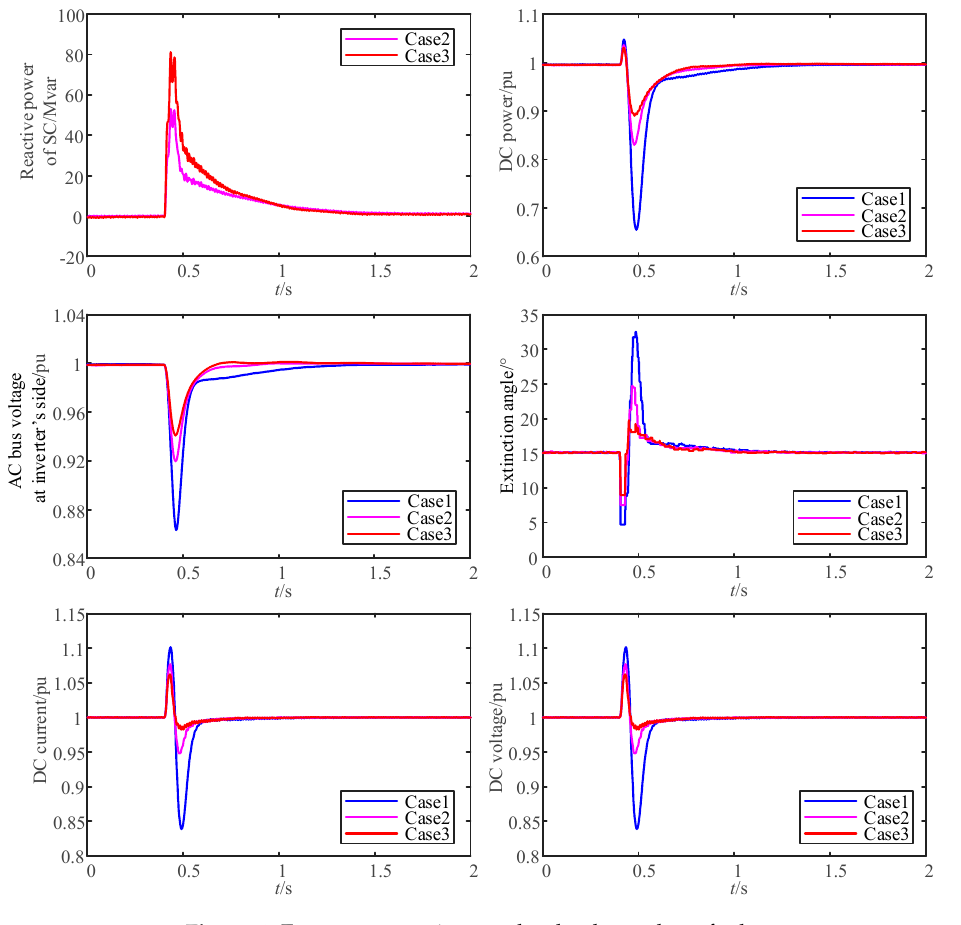
Figure 4. Feature comparison under the three-phase fault.